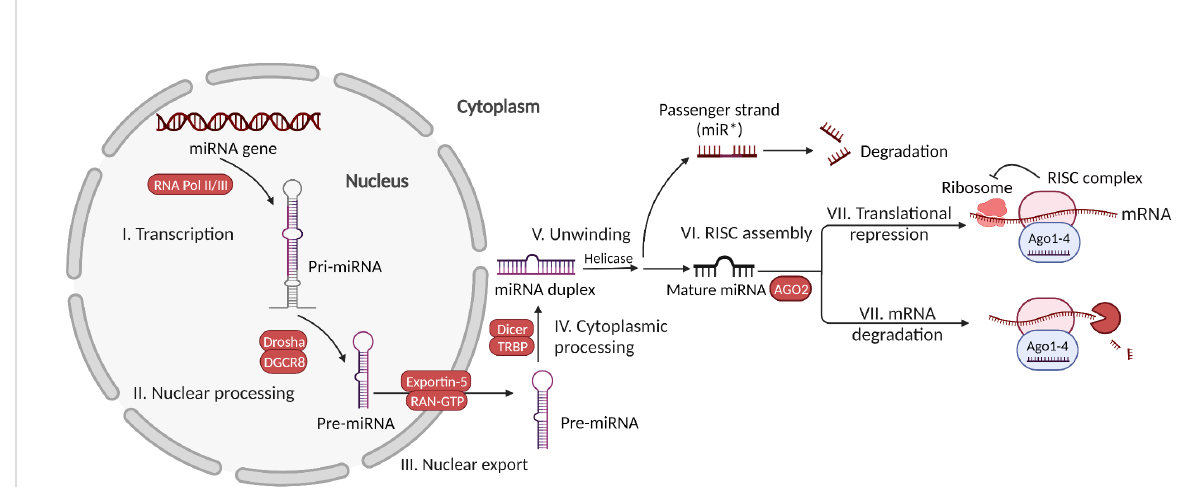
FIGURE 1 MicroRNA biogenesis and functions. Canonically generated miRNAs go through transcription of the miRNA gene, nuclear processing of pri- miRNA, nuclear export of pre-miRNA, cytoplasmic processing of pre-miRNA, miRNA duplex unwinding, and assembly with AGO2 to form the RISC complex. Then, the mature miRNA in the RISC complex can exert functions via either mRNA translational repression or mRNA